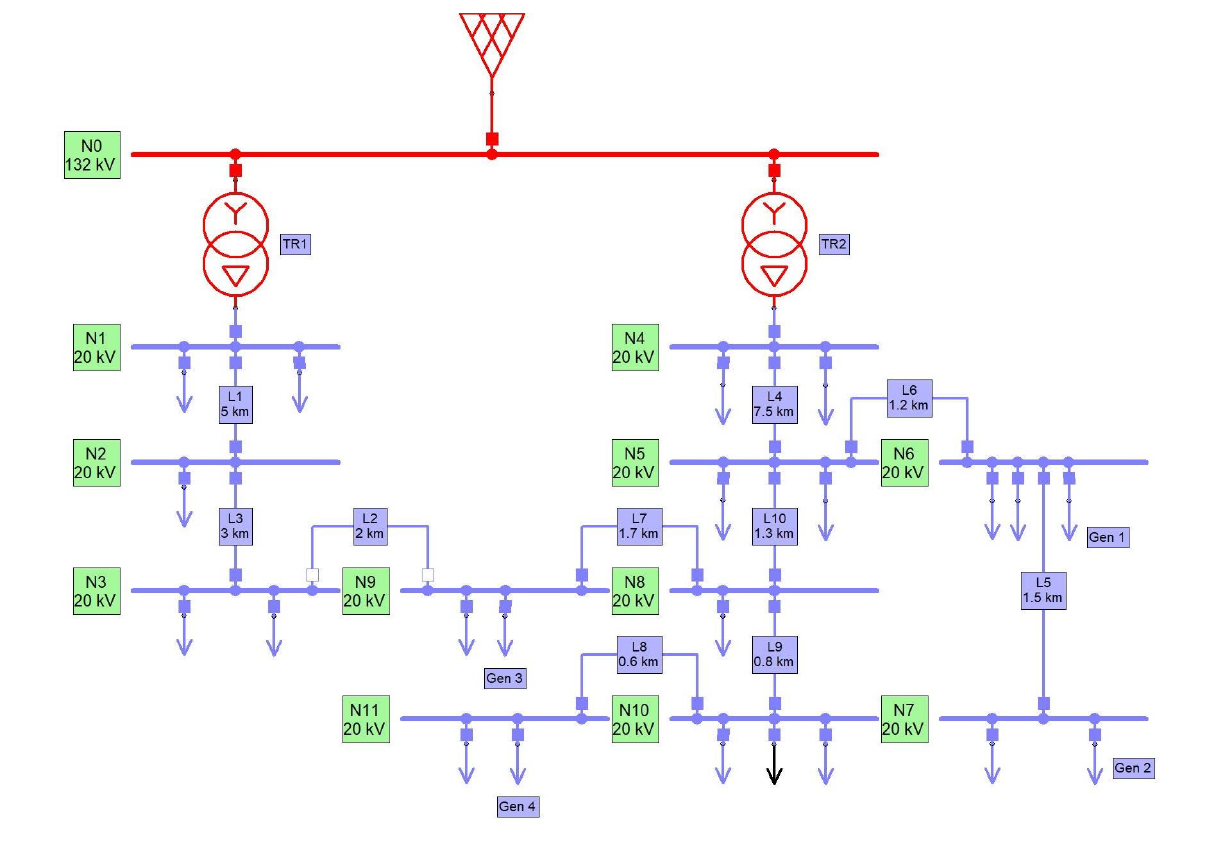
Figure 20. Eleven-Node